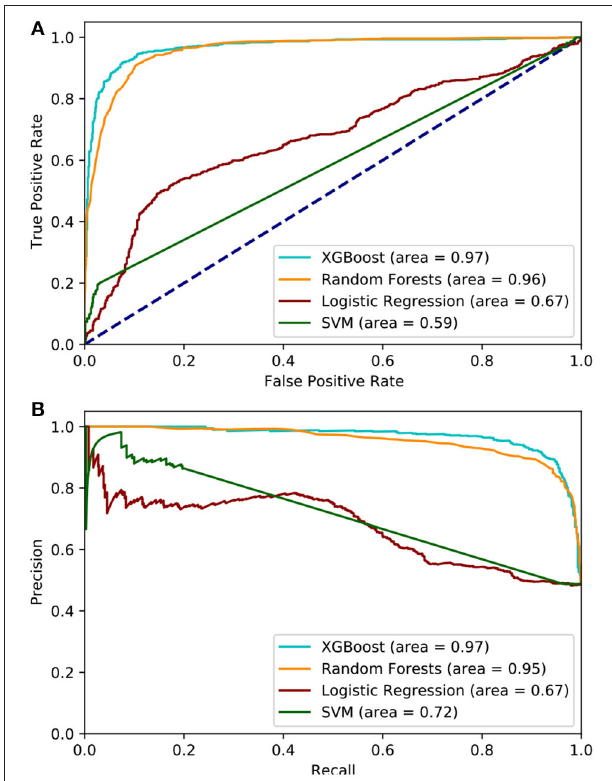
FIGURE 4 | (A) Area under the Receiver Operator Curve, the XGBoost model achieves the highest AUC while SVM performed the worst. (B) area under the Precision Recall curve, XGBoost maintains the best AUPRC but Logistic Regression is ranked the worst.